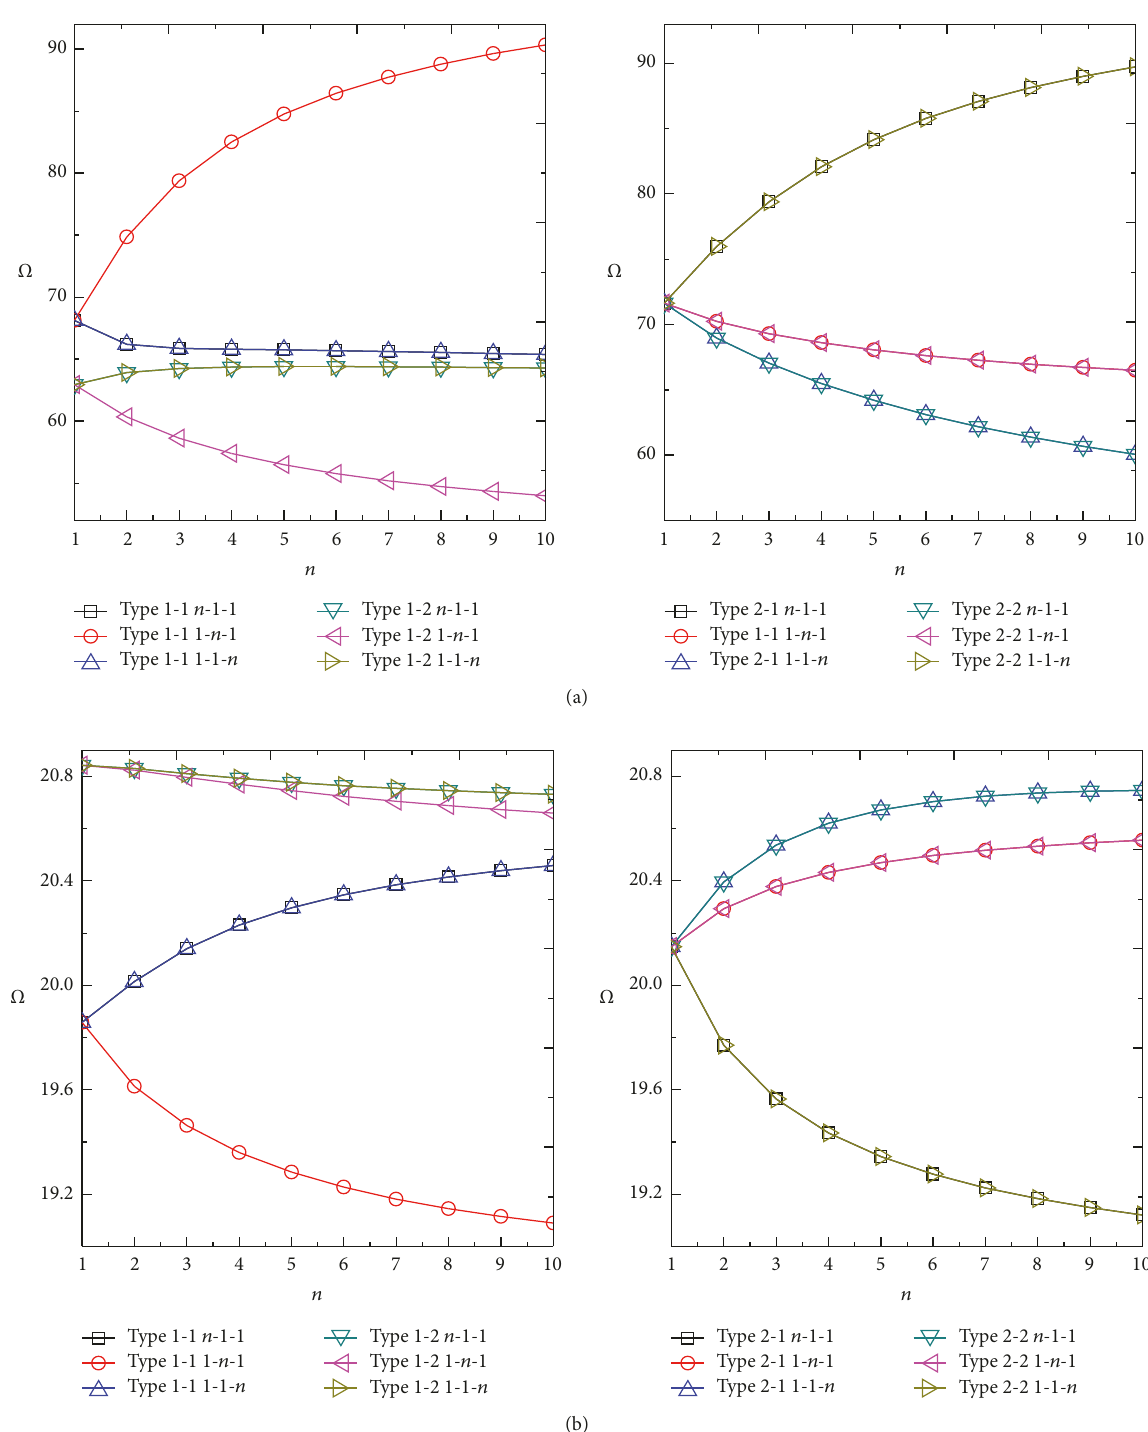
Figure 13: Variations of fundamental frequency parameter Ω of annular sector plate with material types and different thickness schemes ( 𝑅 0 /𝑅 1 = 0.5, 𝜙 = 120 ∘ , ℎ/𝑅 1 = 0.2, and 𝑝 1 = 𝑝 3 = 5): (a) CCCC; (b) E 3 E 3 E 3 E 3